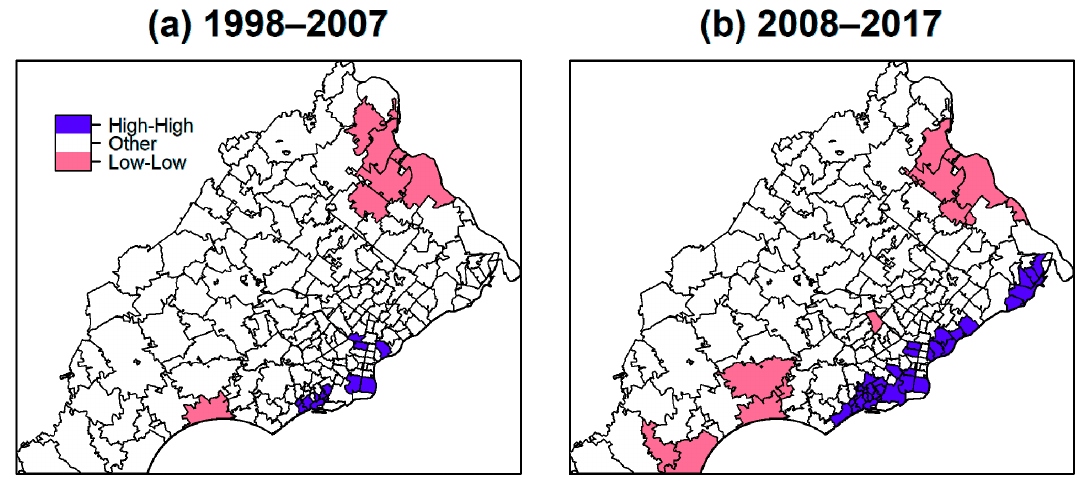
Figure 7. Local Indicators of Spatial Association (LISA) map with high-high and low-low incidence clusters for ( a ) 1998 to 2007 period, and ( b ) 2008 to 2017 period.